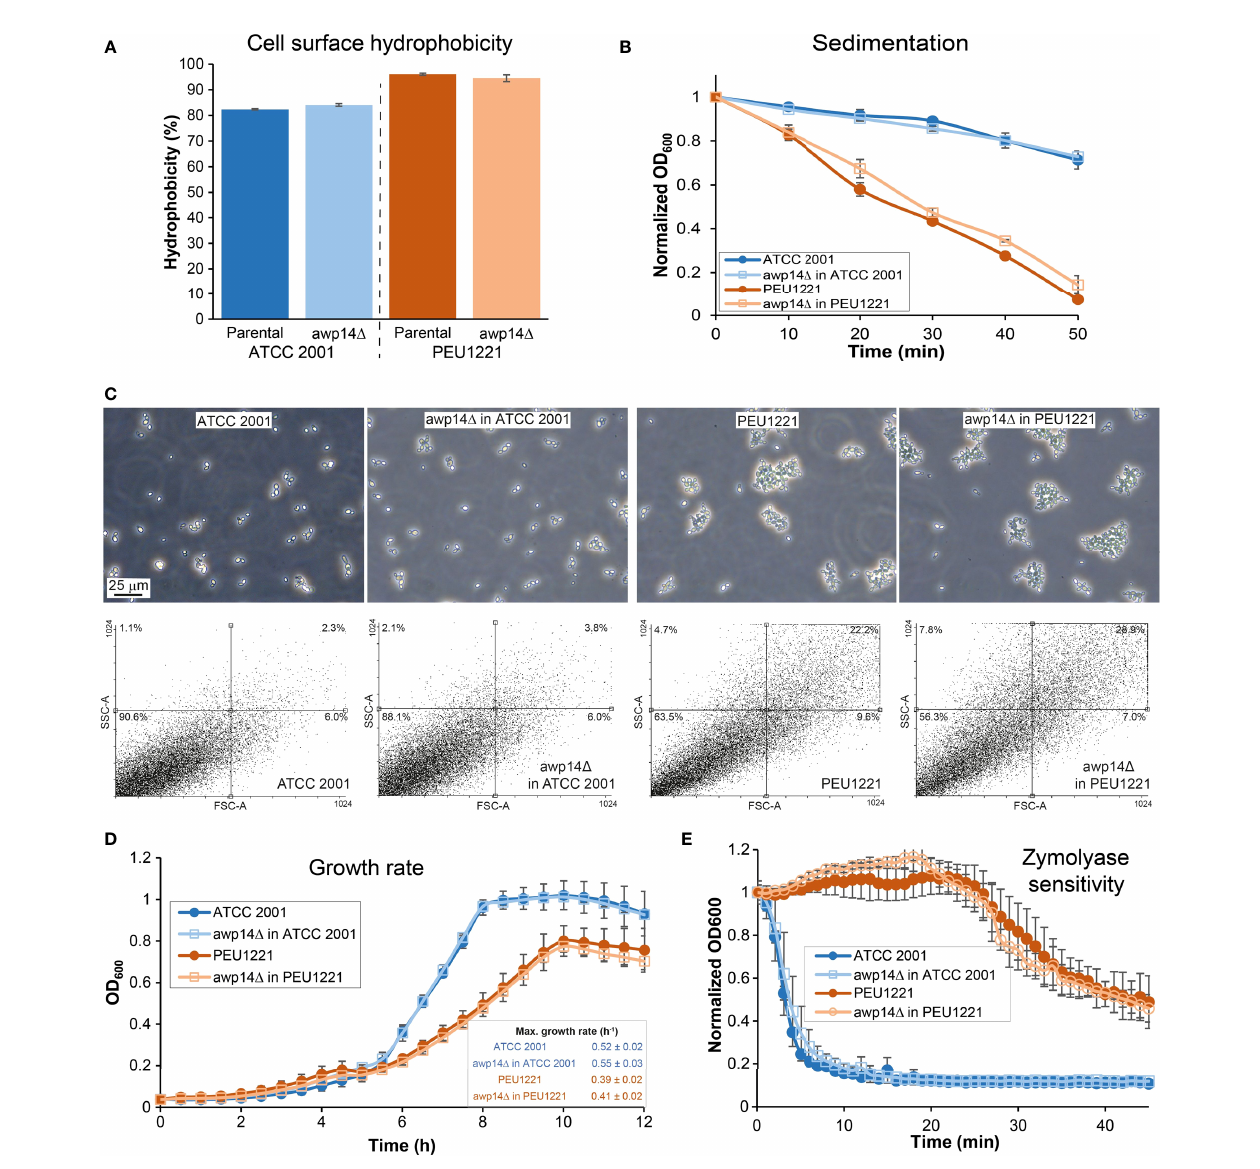
FIGURE 4 | Elimination of AWP14 does not cause (major) alterations in cell surface-related properties in PEU1221 and ATCC 2001. (A) Cell surface hydrophobicity. (B) sedimentation, (C) aggregation, (D) growth rate, and (E) zymolyase sensitivity of parental strains and awp14 D mutants in PEU1221 and ATCC 2001. (C) Aggregation was analyzed by microscopy (Top panel) and fl ow cytometry (Bottom panel) by measuring 20,000 cell particles per strain. FSC-A, particle size; SSC-A, particle complexity. Percentage of cell particles in each quadrant are indicated. Note the increased dot population in the right upper part of the dotblots in PEU1221 background strains indicating cell